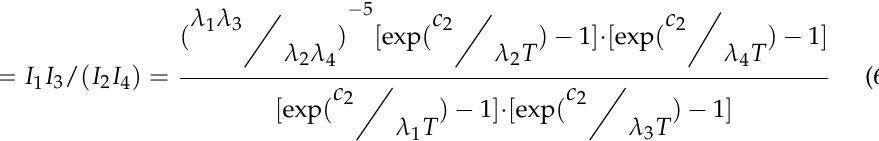
Table 4. The performance of energy release by RMs projectile.